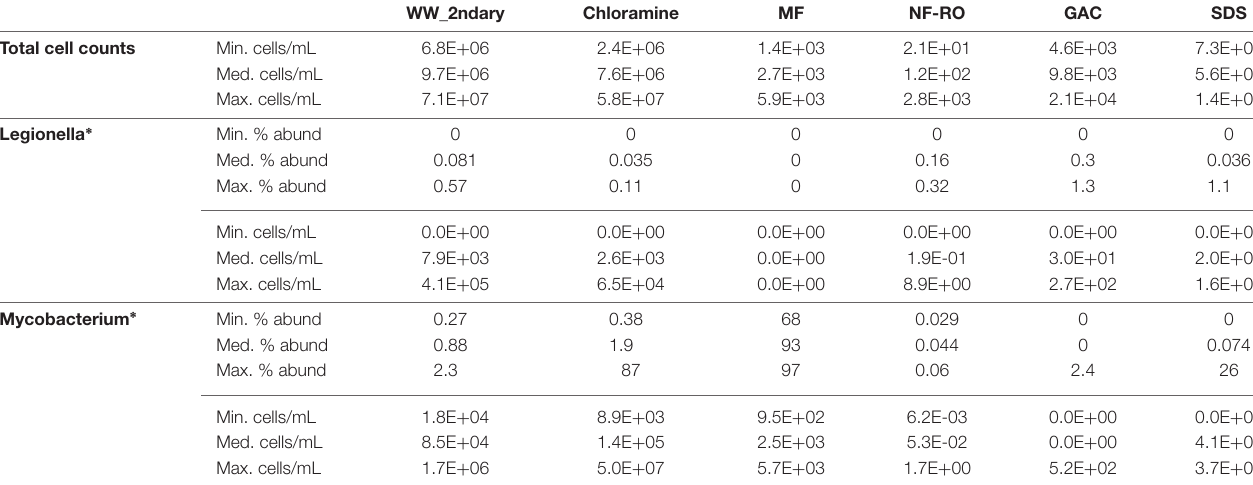
TABLE 2 | Relative and absolute abundance (total cells per milliliter) estimates for genera containing opportunistic